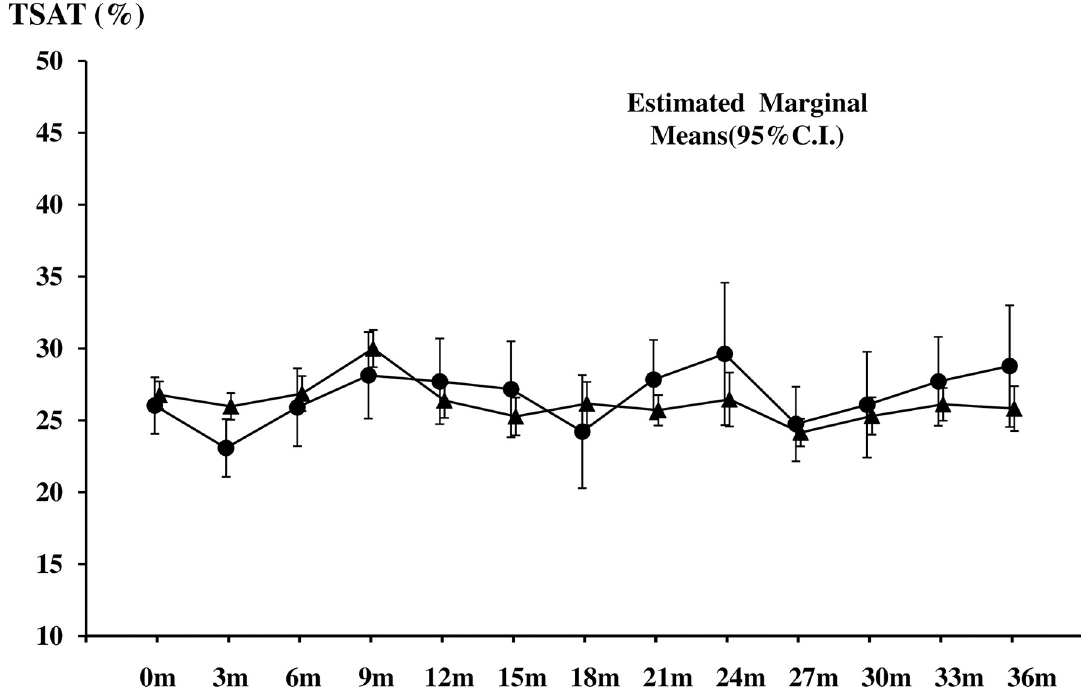
Fig 4. Comparison of TSAT levels between patients receiving or not receiving intravenous iron administration. During the observational period, there was no significant difference in TSAT levels between patients treated with intravenous iron in the past three months and those without this treatment. ● : patients not treated with intravenous iron, ▲ : patients treated with intravenous iron. Data represent means ± SD.